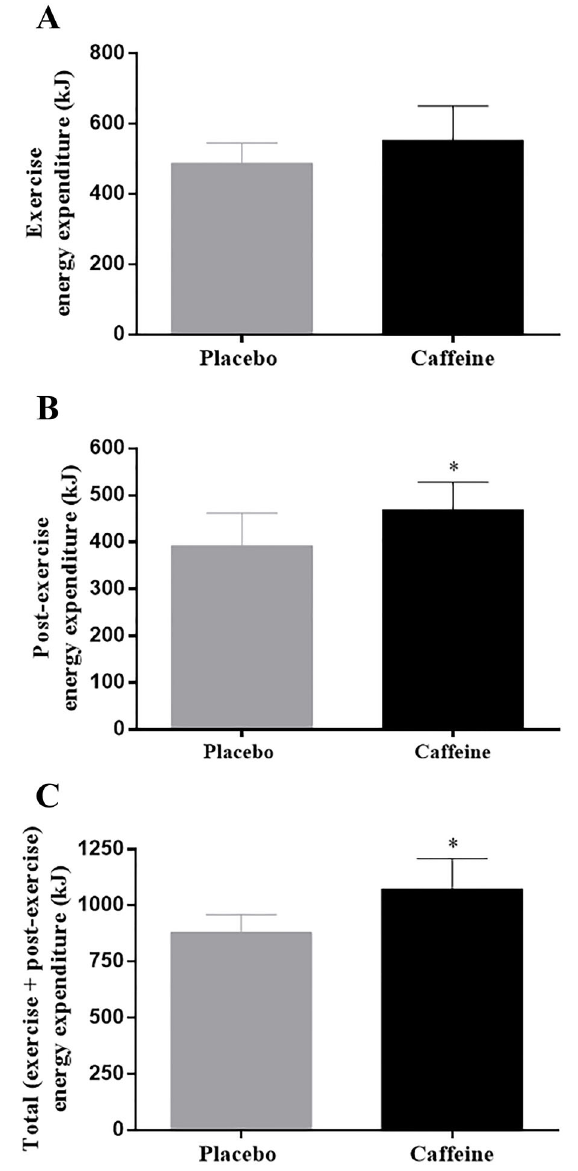
Figure 2. Energy expenditure during ( A ) and post ( B ) a single sprint interval training session, and total energy expenditure (exercise plus post-exercise; C ) in the placebo and caffeine groups. *P o 0.05 (independent t -test). Data are reported as means ± SD, n=10 per